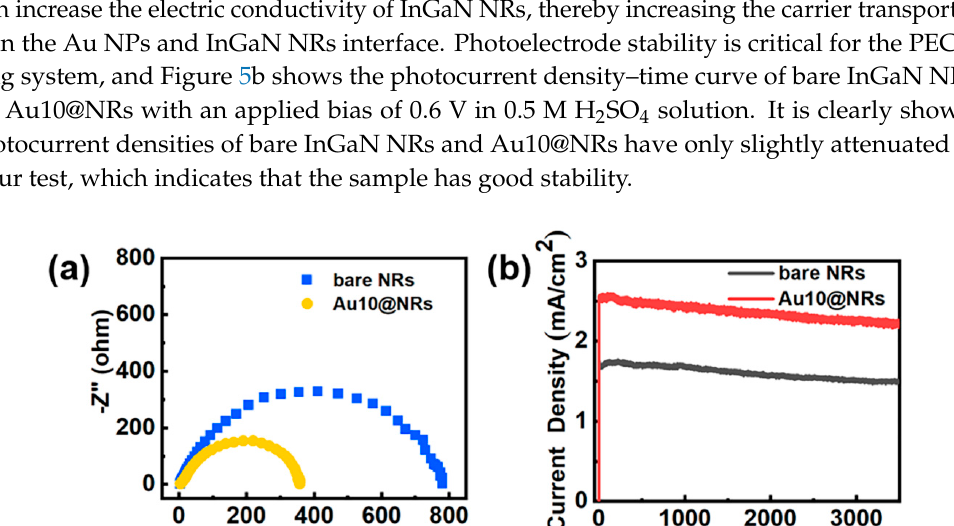
Figure 5. ( a ) Nyquist plots of bare NRs and Au10@NRs. ( b ) Stability of the bare NRs and Au10@NRs photoanodes for photoelectrochemical (PEC) the oxygen evolution reaction (OER).